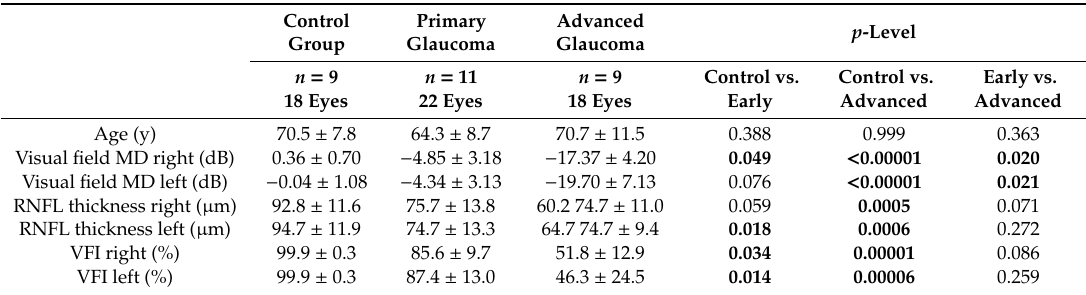
Table 2. Clinical characteristic of the examined groups (means ± SD)—one-way ANOVA statistical analysis (Kruskal–Wallis and Tukey’s test).